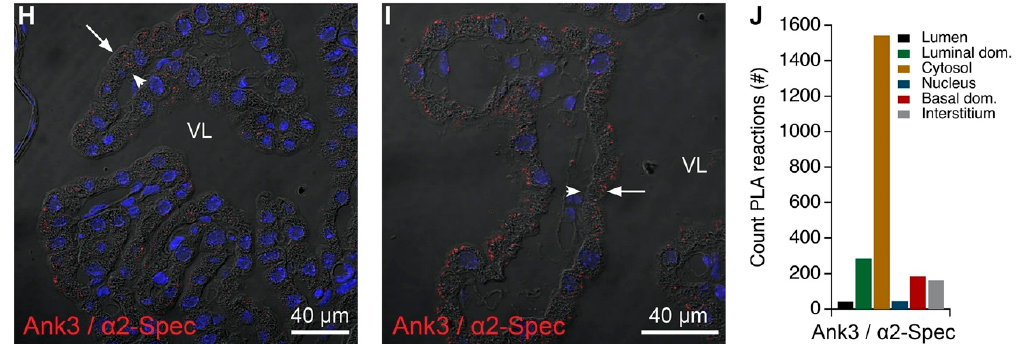
Figure 11. Colocalization of luminal spectrins and Na,K-ATPase α 1 or ankyrin-3 in the CP. ( A ) Immunolocalization of α 2-spectrin (green) in the CP. ( B ) Similar immunolabeling for β 2-spectrin. ( C ) Double immunofluorescence labeling for Na,K-ATPase α 1 (red) and α 2 spectrin (green) in the CPE (same section as panel/image A). ( D ) Double immunofluorescence labeling for Na,K-ATPase α 1 (red) and β 2 spectrin (green) in the CPE (same section as panel/image/micrograph B). ( E ) Representative immunofluorescence image of PLA products (red) using anti- α 2-spectrin ( α 2-spec) and anti-Na,K-ATPase α 1 (NaK α 1) antibodies and cell nucleus counterstain (blue) overlaid on the corresponding DIC image. ( F ) Similar micrograph of the same structure at higher magnification overlaid on the corresponding DIC image. ( G ) Bar graph representing the count of PLA reactions in the indicated image areas. ( H ) Representative immunofluorescence image of PLA products (red) using anti- α 2-spectrin ( α 2-Spec) and anti-ankyrin-3 antibodies (Ank3) and cell nucleus counterstain (blue) overlaid on the corresponding DIC image. ( I ) Similar micrograph of the same structure at higher magnification overlaid on the corresponding DIC image. ( J ) Bar graph representing the count of PLA reactions in the indicated image areas. Arrows indicate luminal surfaces, while arrowheads mark basolateral surfaces. VL denotes the fourth ventricle